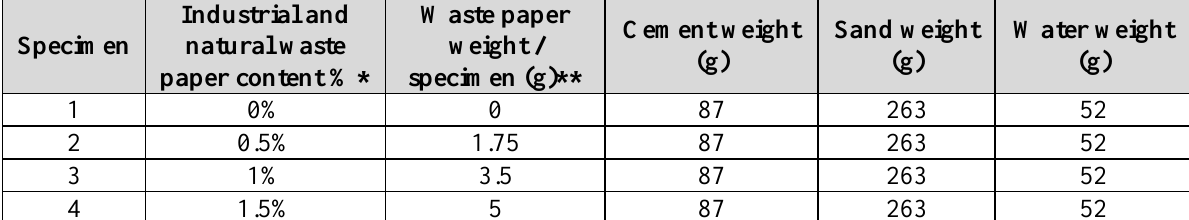
Fig. 4: Compression test specimens. Table 2: The composition of the cubic